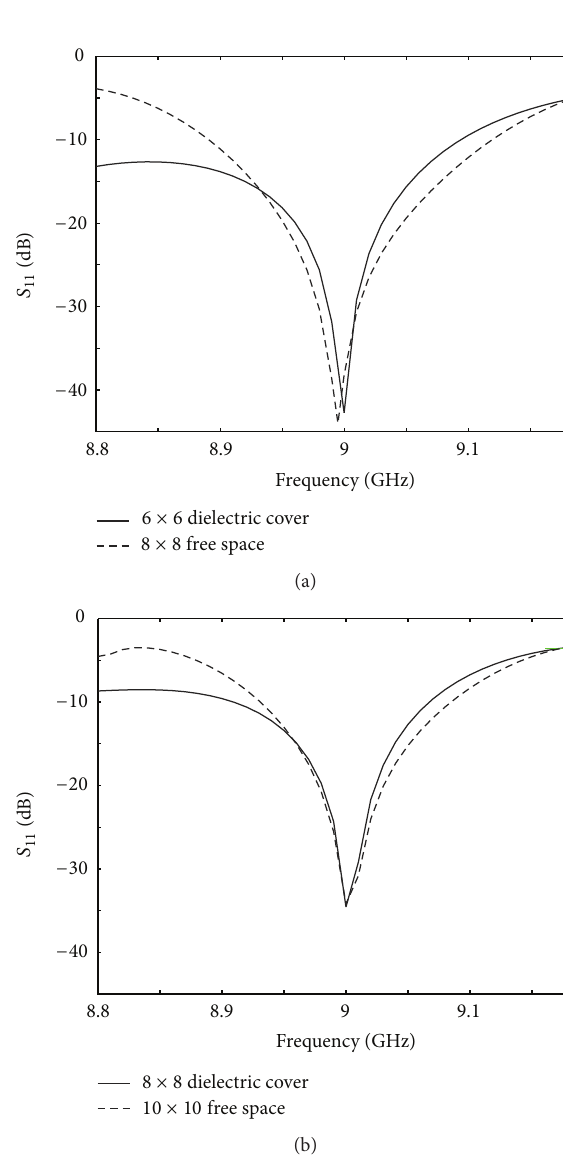
Figure 5: Simulated gain (HFSS) of 8 × 8 array with dielectric cover and 10 × 10 radiating in free space. 𝐷 𝑃 = 260 mm.